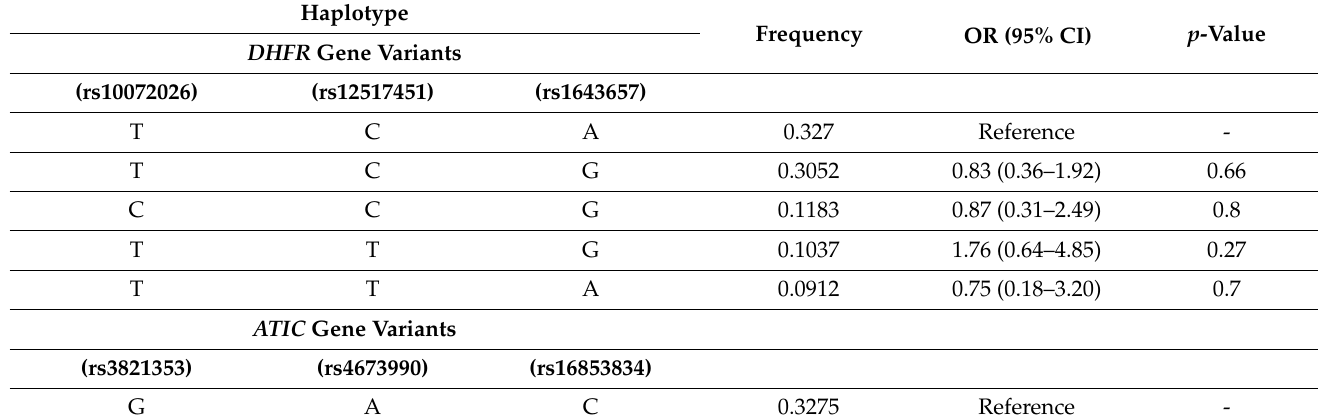
Table 6. Haplotypes of methotrexate pathway gene variants and the treatment response to methotrexate.